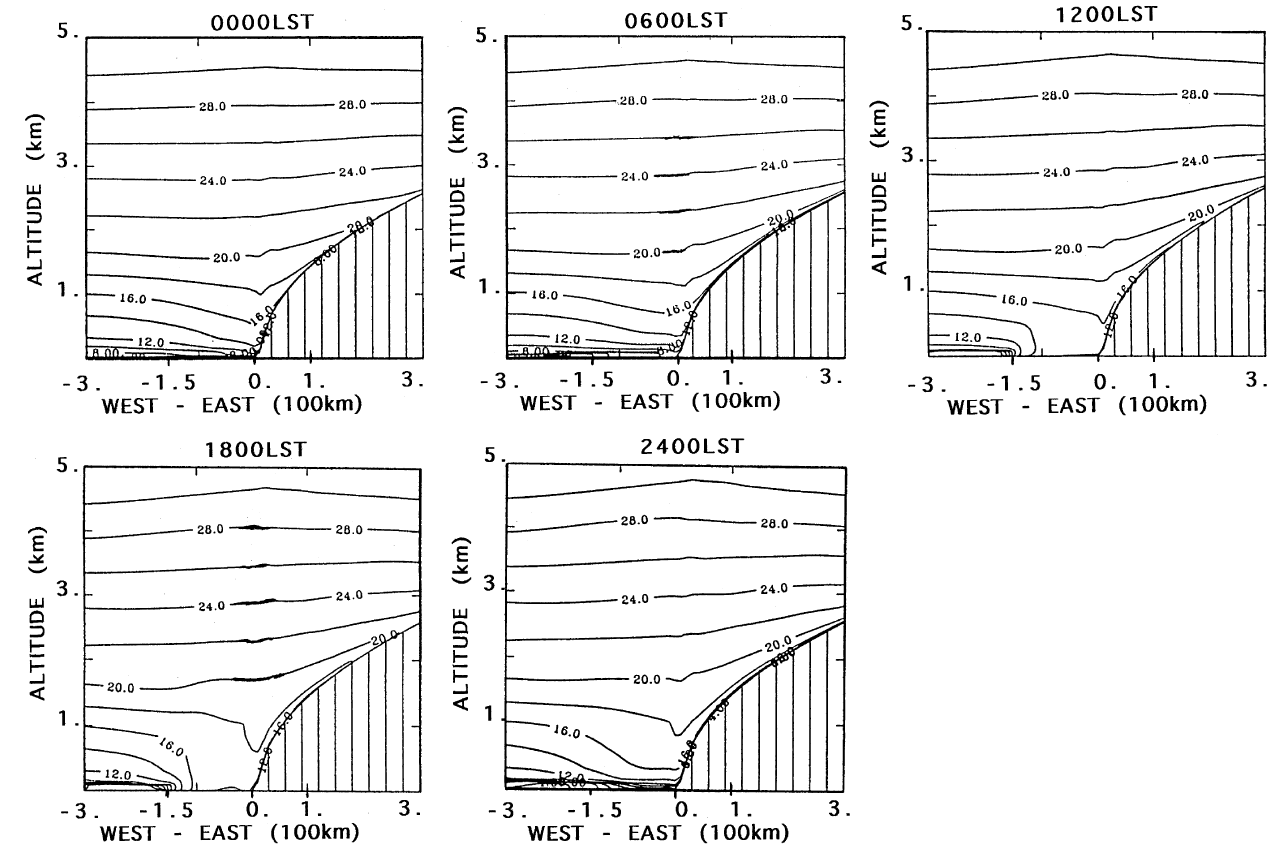
Fig. 4. Potential temperature fields computed on July